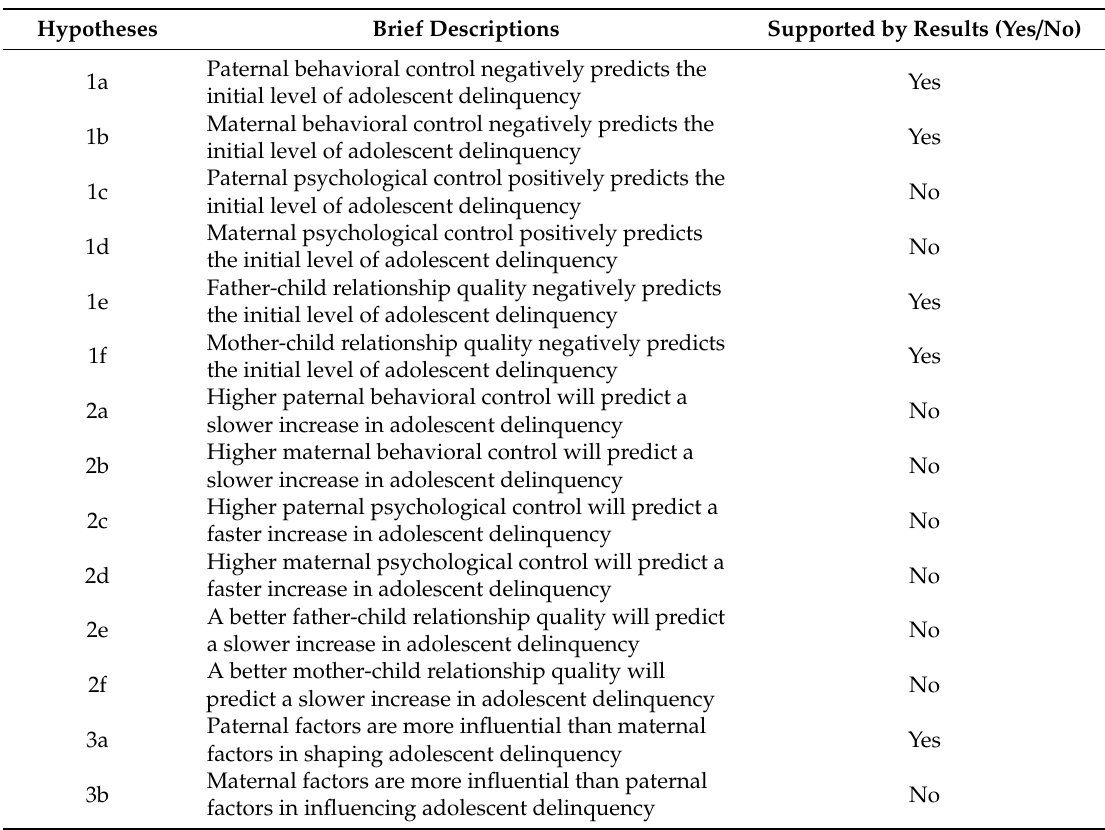
Table 1. Hypotheses of the present